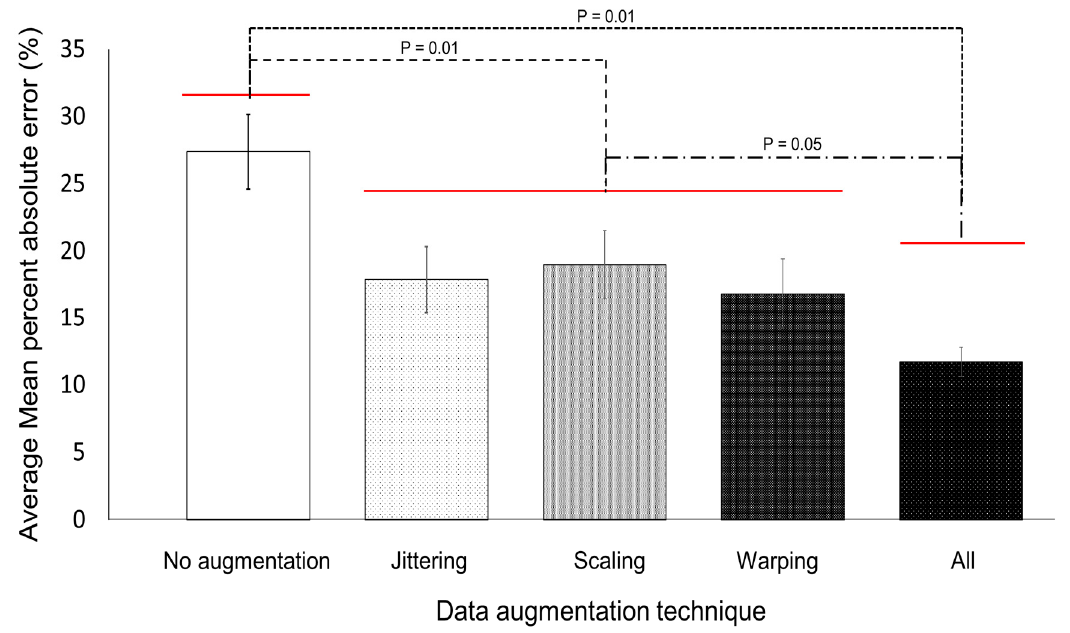
Figure 7. Regression analysis of pre-impact fall impact acceleration magnitude prediction at different directions. ( a ) the regression analysis of impact acceleration prediction for forward fall; ( b ) the regression analysis of impact acceleration prediction for backward fall; ( c ) the regression analysis of impact acceleration prediction for leftward fall; ( d ) the regression analysis of impact acceleration prediction for rightward fall; ( e ) the regression analysis of impact acceleration prediction for straight fall.